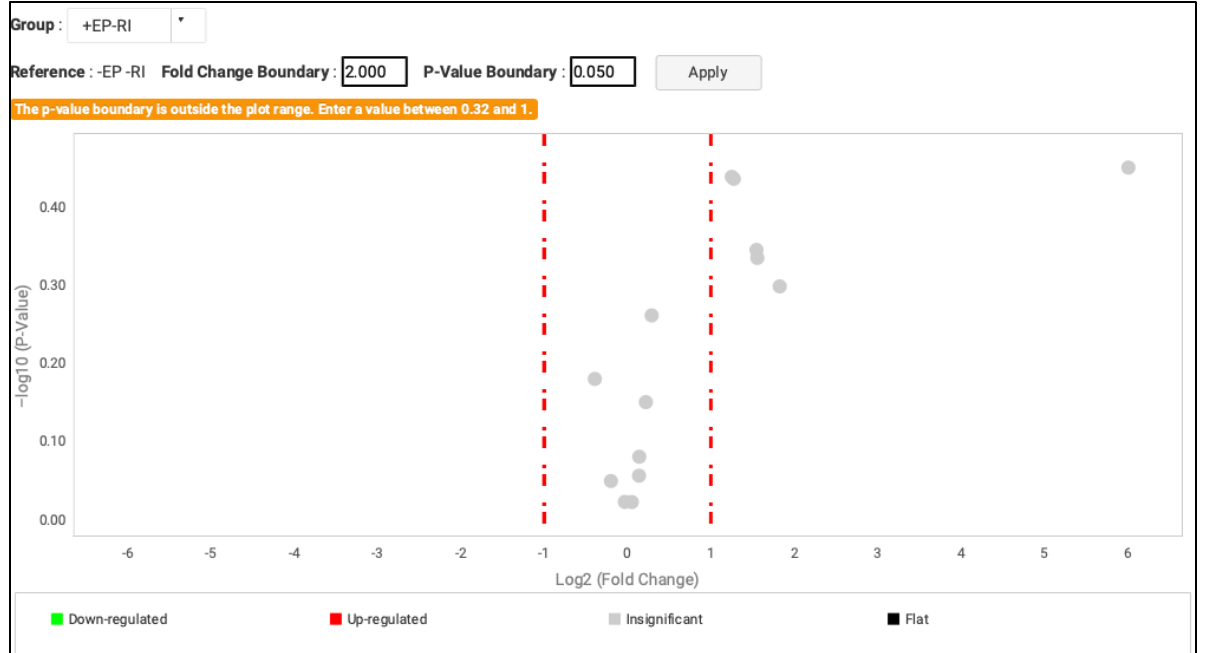
Figure 2. Volcano plot thermo image. Comparison of the results PD+RI − VS PD − RI − (statistical analysis using the t -test; fold change boundary: 2.000; p -value boundary: 0.05). All the isotherms studied, MT1F (FD 1.036; p = 0.9495), MT1X (FD 1.103; p = 0.8305), MT1E (FD 2.421; p = 0.36544), and MT2A (FD 0.762; p = 0.6600), MT1B (FD 3.549; p = 0.5021), MT1H (FD 2.945; p = 0.4616), MT1L (FD 1.100; p